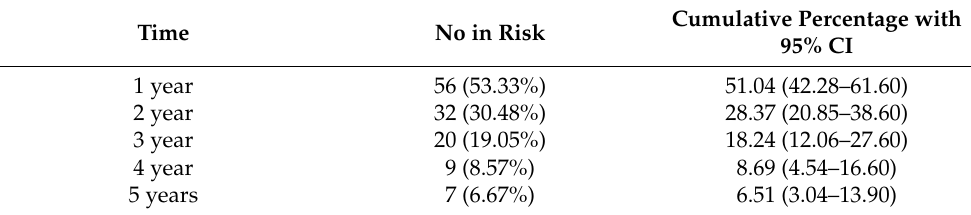
Table 1. Cumulative percentage of yearly post-recurrence survival.